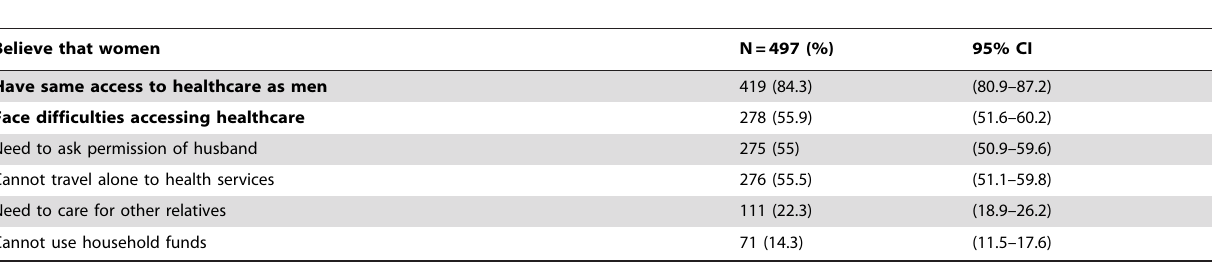
Table 4. Reasons why women face difficulties accessing healthcare facilities (Questionnaire 1).